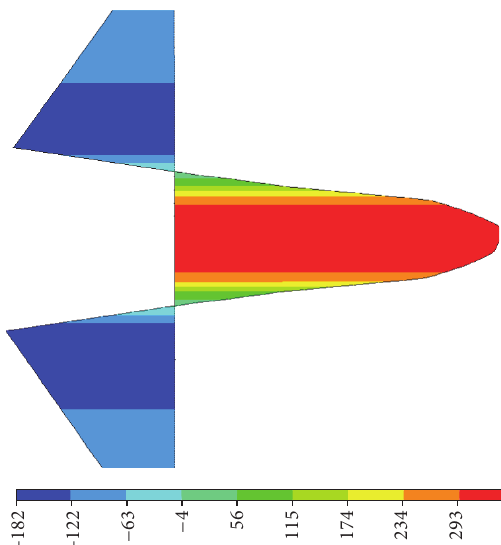
Figure 5: Stress distribution in longitudinal direction 𝜎 𝑥 [MPa] caused by welding in longer flange used in finite element